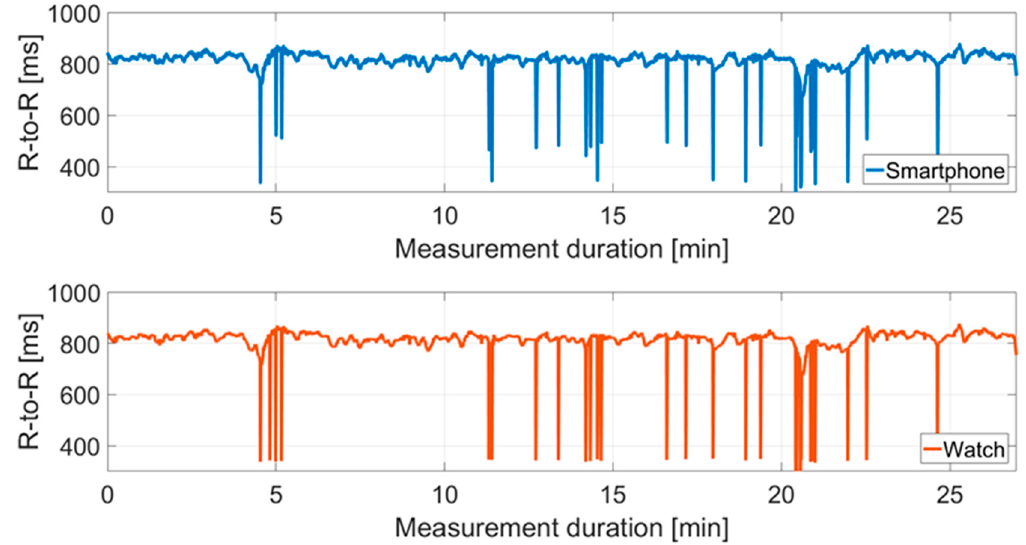
Figure 4. Comparison between the mean RR intervals (R-to-R) (ms) of the two signals in the raw data set derived from the smartphone IoTool application and the Polar watch V800 for Cow I over the experimental period of 27 min ( n = 3630 measured values).